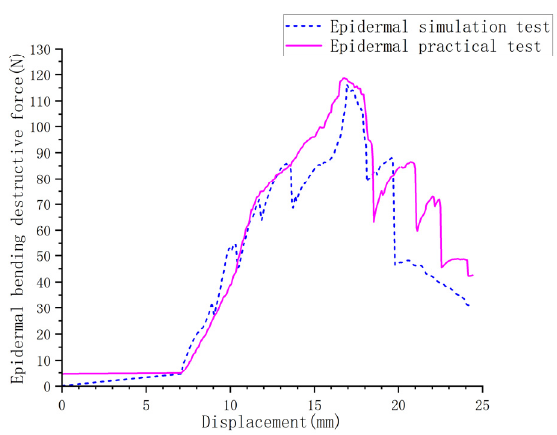
Figure 11. Comparison of bending damage force results of straw epidermis.